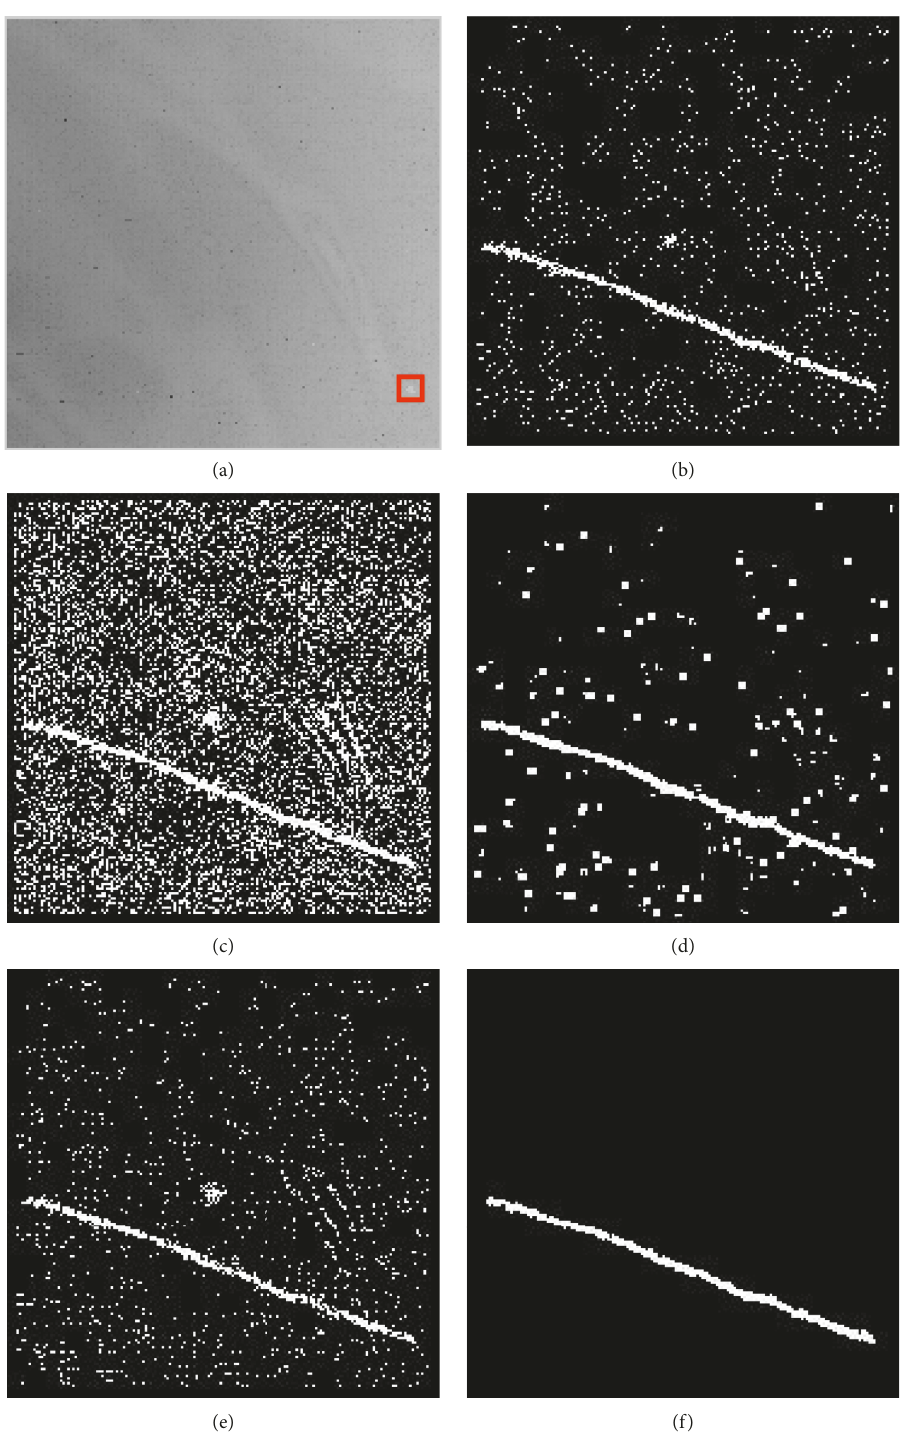
Figure 6: Detection results of different algorithms in scene